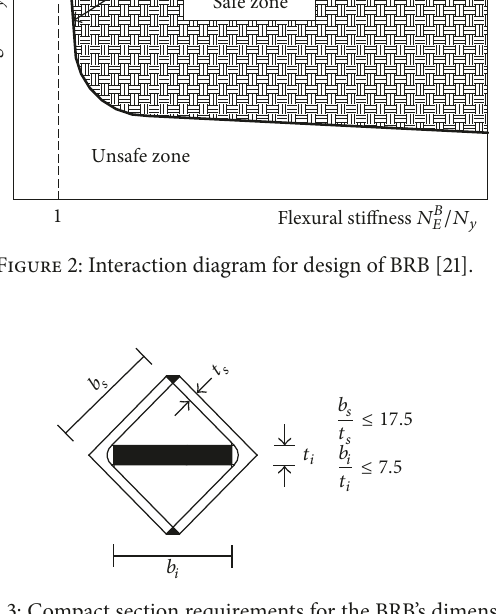
Figure 3: Compact section requirements for the BRB’s dimensions [5].